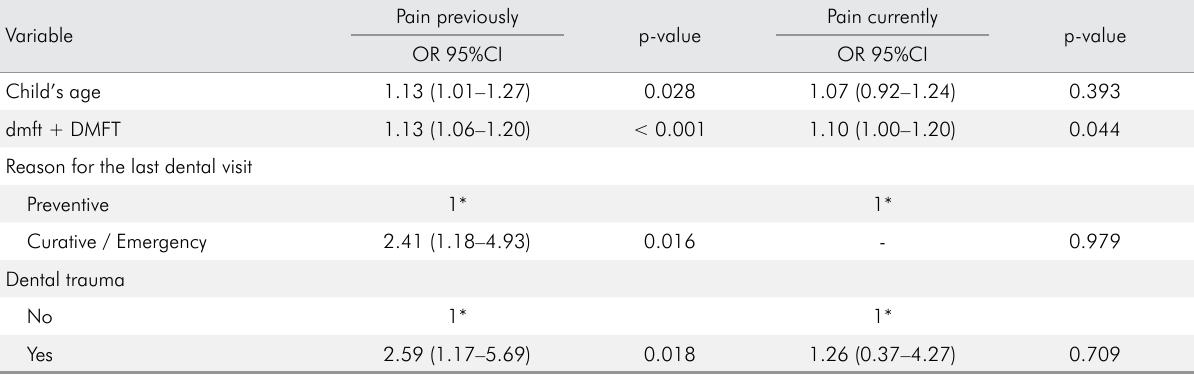
Table 3. Multivariate analysis of dental pain and the independent variables.